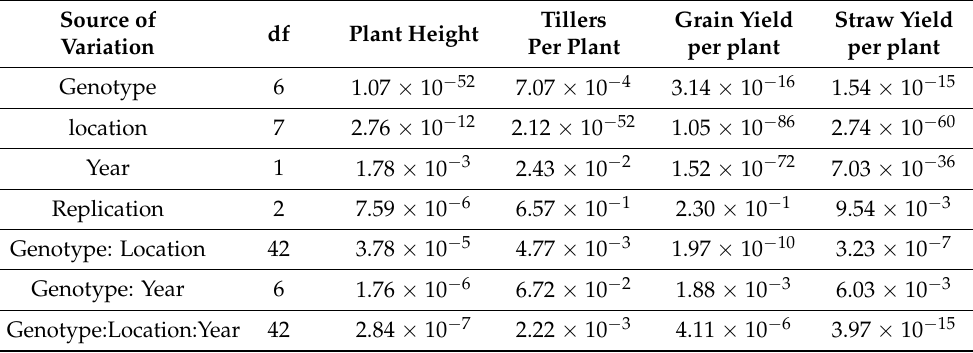
Table 3. Estimation of significant levels for yield and related traits of seven rice genotypes revealed by combined ANOVA.